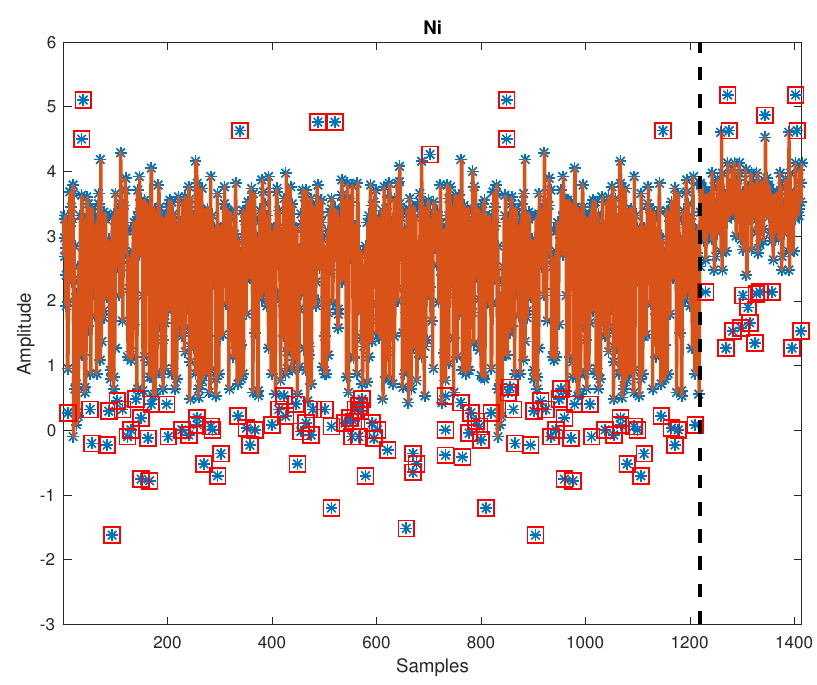
Figure 6. Outlier detection result on Cd.